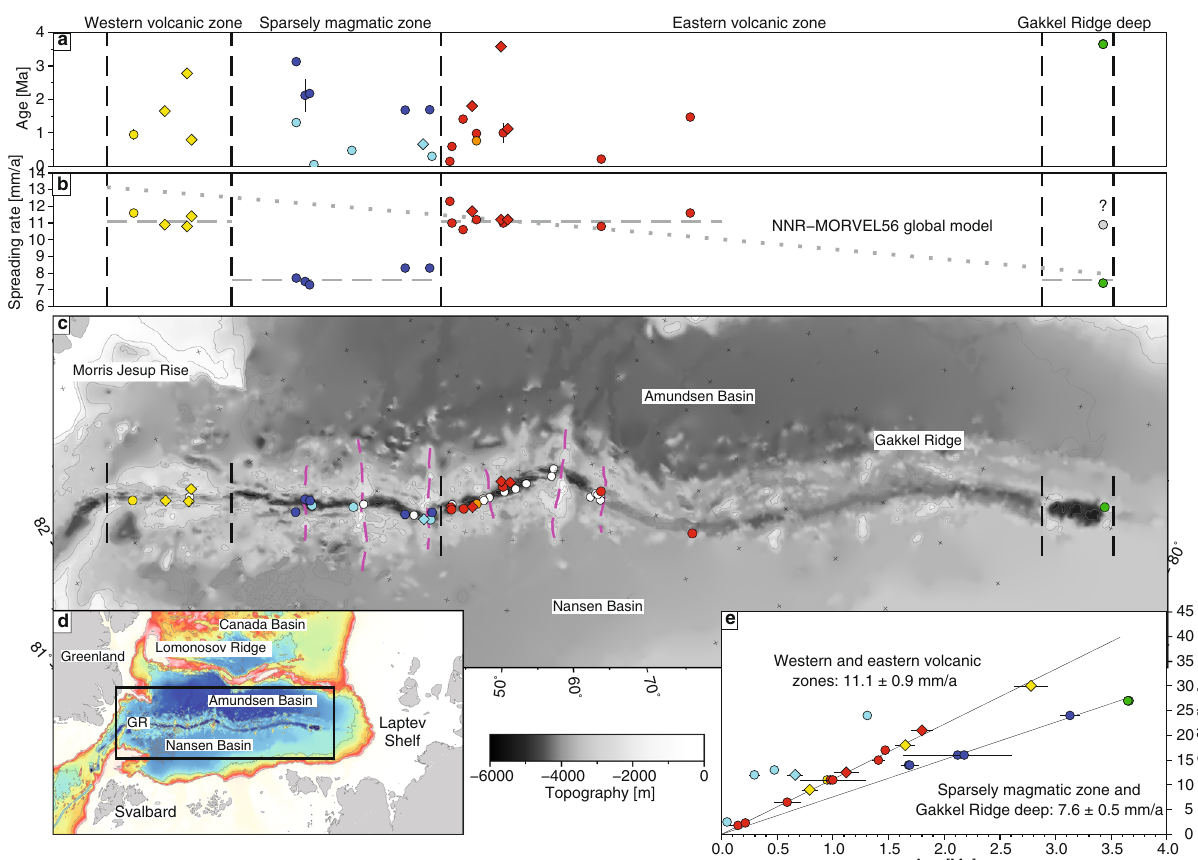
Fig. 1 Relation between spreading rate and magmatism along the Gakkel Ridge. All panels refer to Table 1 and Figs. 2 – 5. Yellow, blue, red and green symbols represent samples with reliable spreading rates. Light blue symbols are for samples that do not yield realistic spreading rates due to their mode of emplacement. The orange dot marks a sample without a pro fi le. The diamond symbols are for samples with dates that fail on the data quality criteria discussed in the ‘ Methods ’ section. Error bars for age data are 2 σ uncertainty. Black dashed lines mark the boundaries of the different volcanic regimes. a Distribution of isotopic ages along Gakkel Ridge b Distribution of calculated spreading rates along the ridge. The question mark and open symbol are for an inferred ‘ fast ’ spreading rate at the eastern end of the GRD. The ‘ slow ’ spreading rate estimated for the eastern end of the GRD corresponds to the abrupt narrowing of the rift valley extending into the Laptev Sea. Thus, the ‘ slow ’ spreading rate calculated for the eastern end of the GRD likely continues to the east. The dotted line is for average spreading rates for the past 3 Ma calculated with the NNR-MORVEL56 global model 8 . c Topography of the Gakkel Ridge 56 and the distribution of dated samples along the ridge. Smaller white dots are for samples that did not yield ages. Pink dashed lines are for well- de fi ned centres of focussed magmatism 10 . d Map of the study area, GR; Gakkel Ridge. e Average spreading rates calculated using the combined age- distance pro fi les. A robust linear regression (forced through the origin) yields an average spreading rate of 11.1 ± 0.9 mm/yr for the WMZ and EVZ. A poorly constrained rate of 7.6 ± 0.5 mm/yr is inferred for four SMZ and a single GRD-LS sample whereas the other SMZ samples do not predict a consistent spreading rate. An average of all the SMZ data, excluding the sample that does not meet all the data quality criteria, also yields a slow rate (8.1 mm/yr). Note that in some cases samples with large errors overlap high-precision data. This fi gure was created with GMT 57